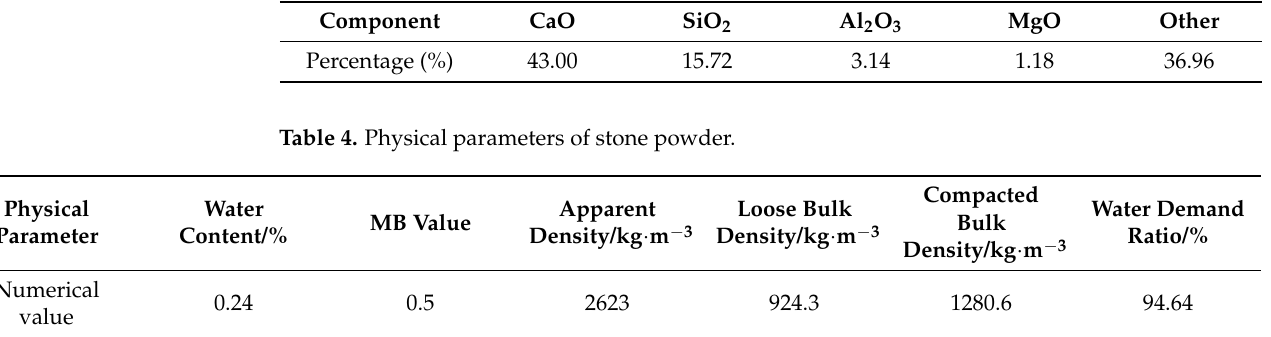
Table 3. Main chemical components of stone powder (%).